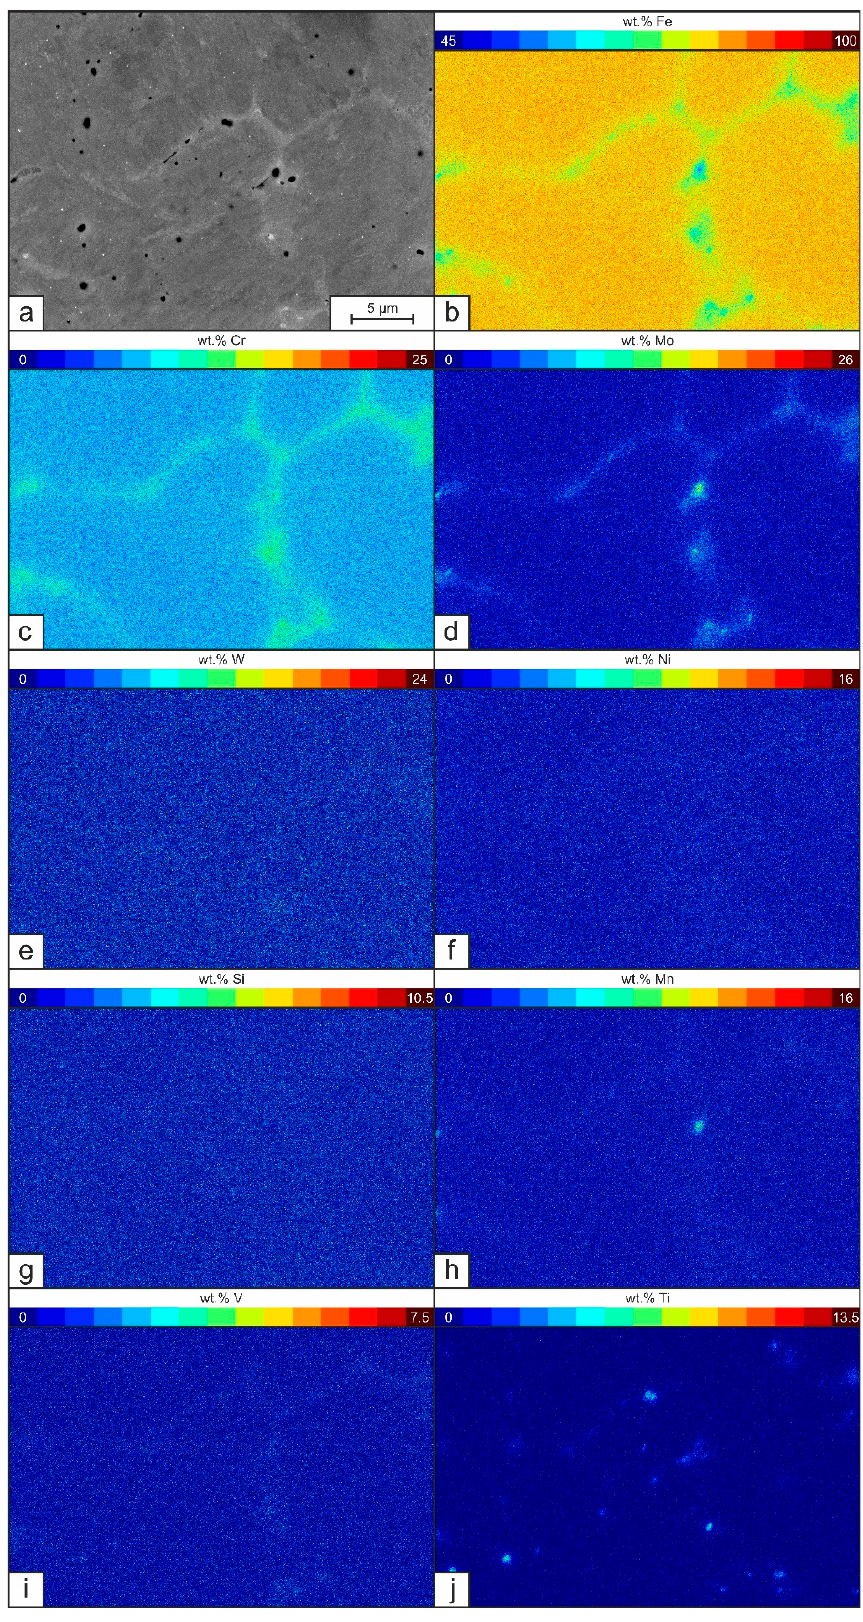
Figure 4. ( a ) SEM picture and EDS element mappings ( b ) Fe, ( c ) Cr, ( d ) Mo, ( e ) W, ( f ) Ni, ( g ) Si, ( h ) Mn, ( i ) V and ( j ) Ti of segregations in a single layer weld of tool steel X36 in as-welded condition.